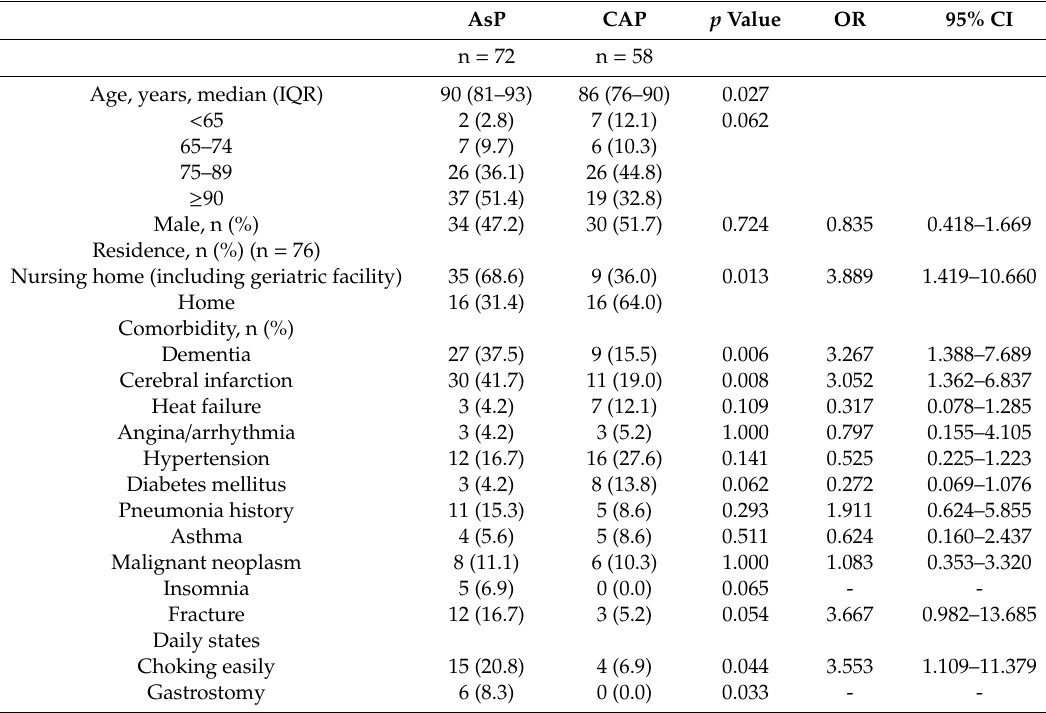
Table 1. General background data of patients with AsP and